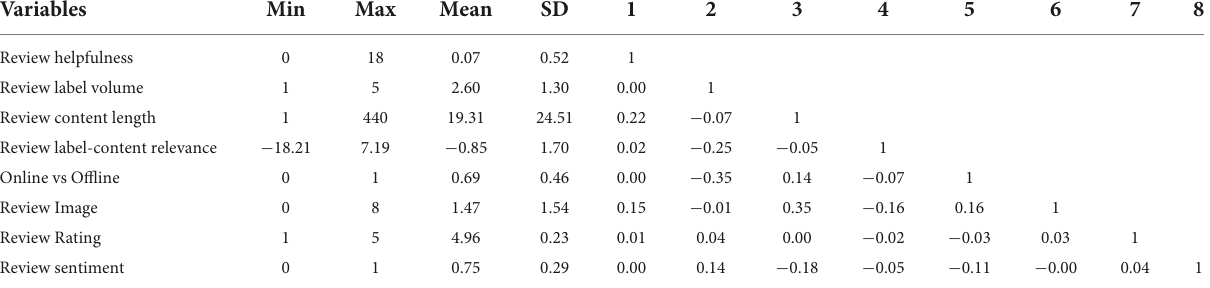
TABLE 1 Descriptive statistics ( n = 2,822).